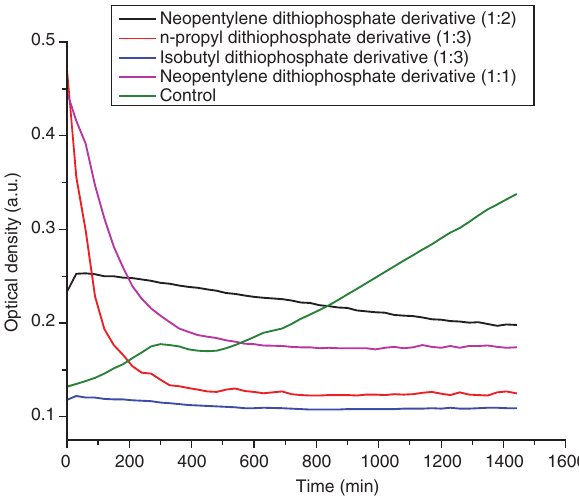
Figure 2: Antimicrobial effect of dithiophosphate derivatives on Staphylococcus